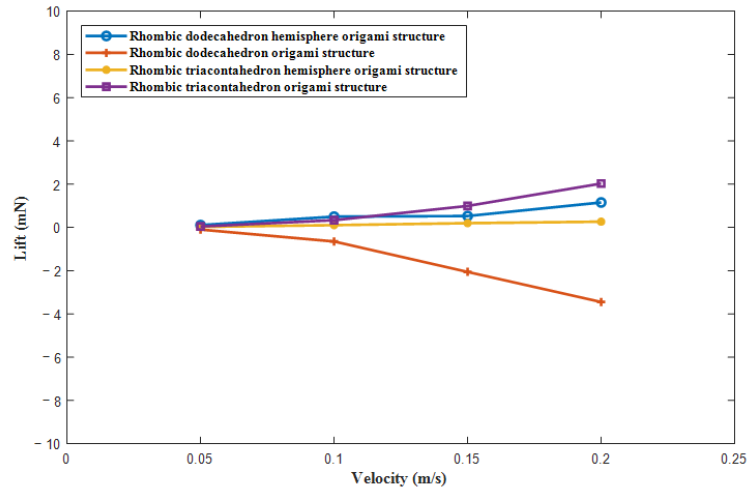
Figure 6. The relationship curve between lift and swimming speed of different origami structures.